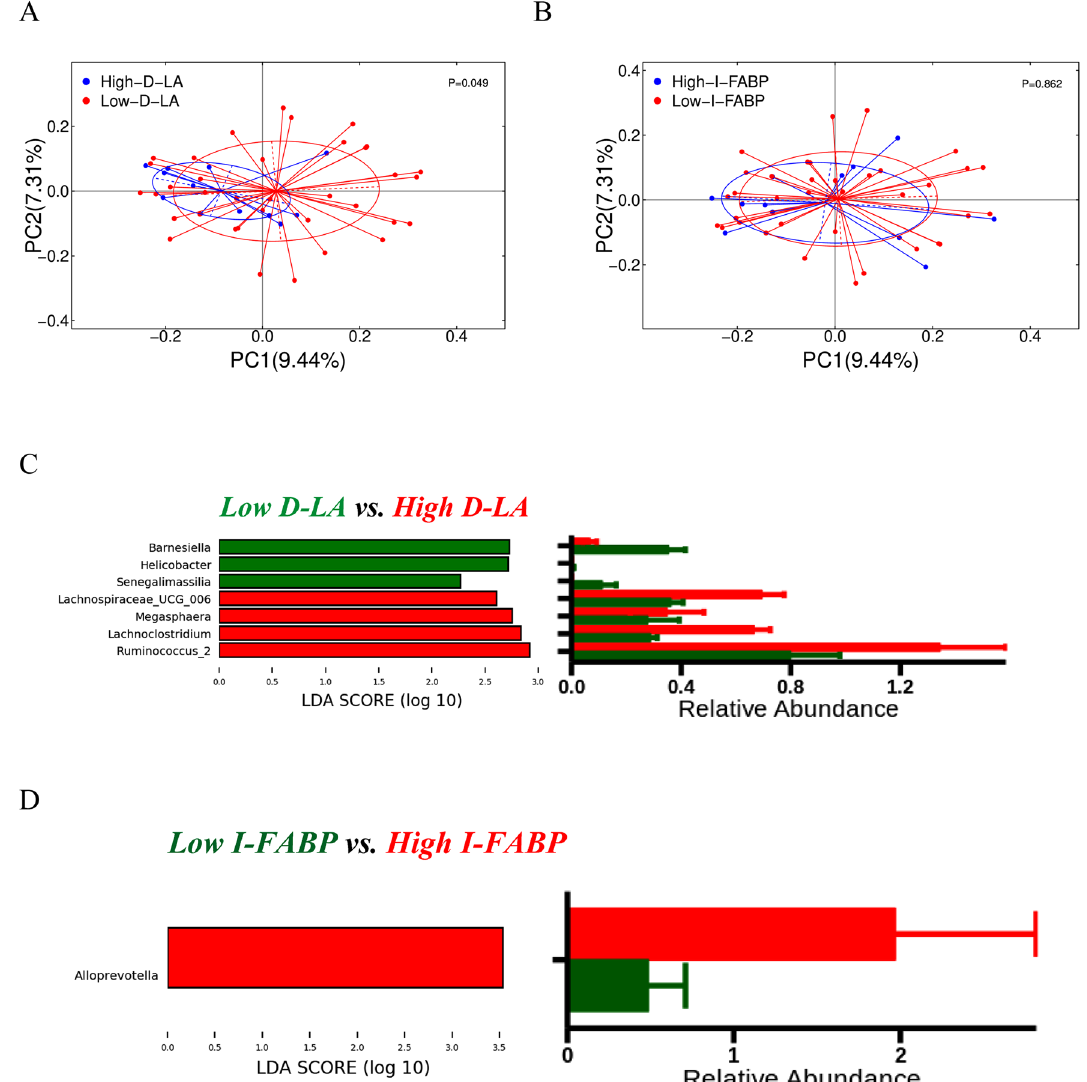
Figure 5. Correlation between changes in intestinal microbiota and intestinal barrier dysfunction. Beta diversity between ( A ) high versus low D-LA (Adonis p = 0.049) and ( B ) high versus low I-FABP levels (Adonis p = ns). ( C ) The gut microbiota with high D-LA was enriched with Ruminococcus_2, Lachnoclostridium, and Lachnospiraceae_UCG_006 and decreased with Senegalimascilia (Wilcox). ( D ) The gut microbiota with high I-FABP was enriched with Alloprevotella